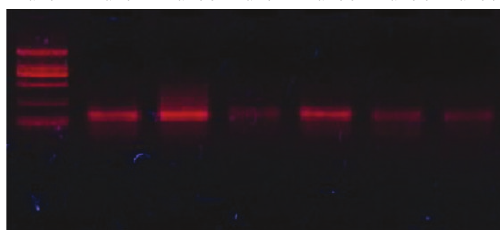
Figure 4: Distribution of the eukaryotic expression vector pro- moter CMV in tissues of TPI group mice treated with recombinant attenuated S. typhimurium strains. Lane 1: DNA marker DL2000; lane 2: liver tissue as template; lane 3: spleen tissue as template; lane 4: kidney tissue as template; lane 5: tumor tissue as template; lane 6: lung tissue as template; lane 7: intestine tissue as